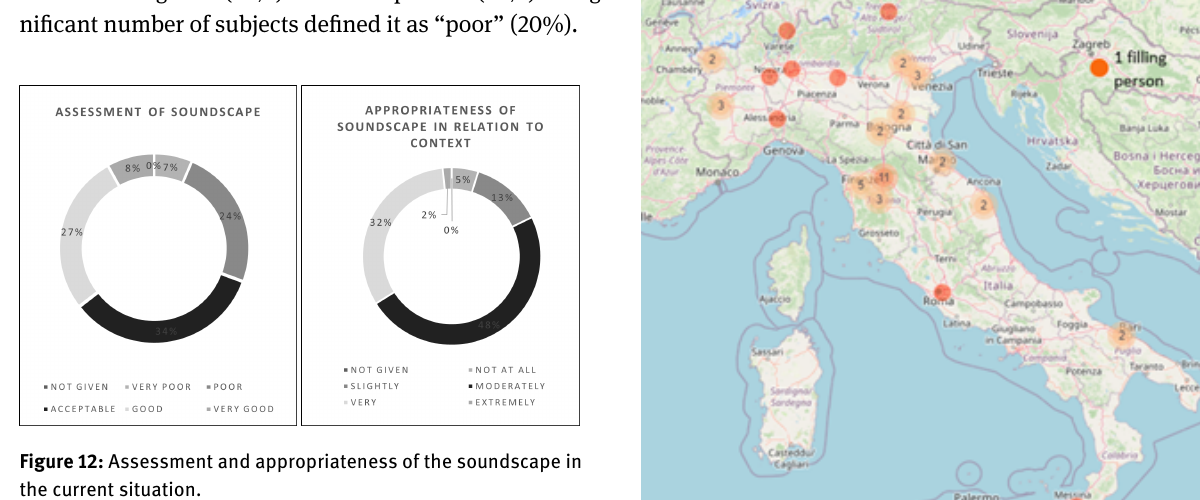
Figure 13: Overall assessment of the environment in the current situation.